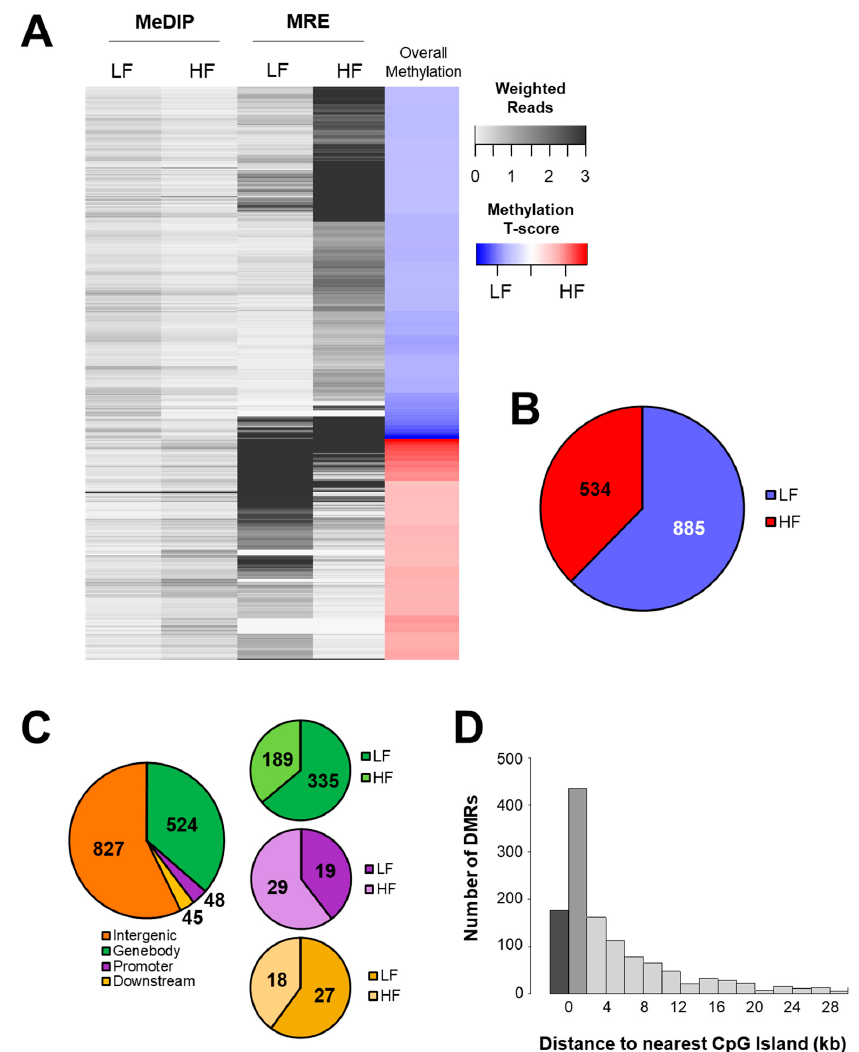
Figure 2. Maternal diet altered hepatic DNA methylation. ( A ) MeDIP-seq and MRE-seq were performed to quantify genome-wide DNA methylation. ( B ) Sequencing revealed 1,419 differentially methylated regions (DMRs) between groups (false discovery rate, FDR, p -value < 0.05), including 534 (37.6%) that were more highly methylated in the HF group and 885 (62.4%) that were more highly methylated in the LF group. ( C ) DMR position relative to genomic features, including intergenic regions, gene bodies, promoters, and downstream regions. ( D ) DMR location relative to CpG islands and shores.